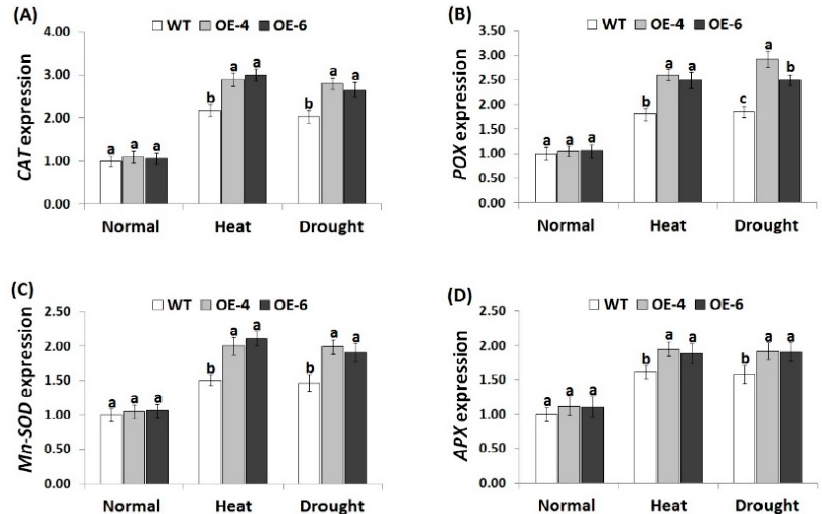
Figure 6. Expression levels of CAT (A) , POX (B) , Mn-SOD (C) , and APX (D) genes in wild type and transgenic wheat lines under normal and stress treatments. Data indicate means ± SE ( n = 4). Different letters above columns represent significant difference ( p ≤ 0.05).